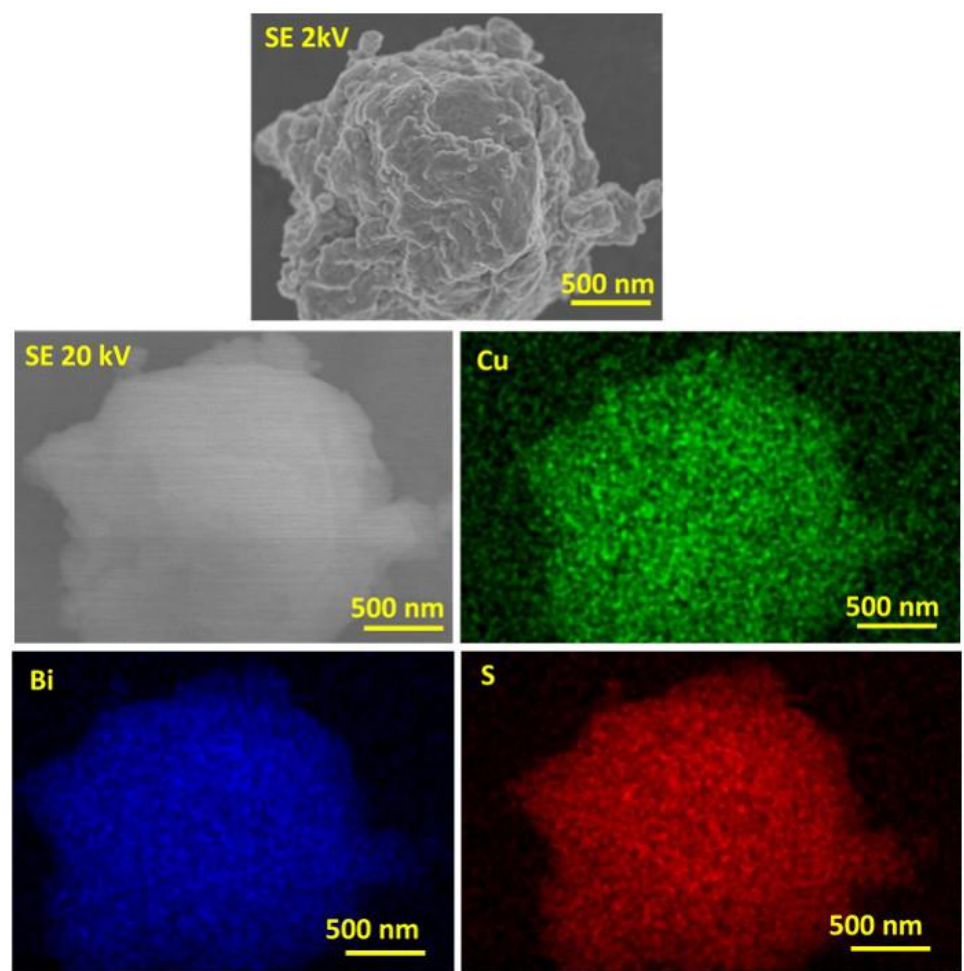
Figure 5. SEM images (2 and 20 kV) of mechanochemically synthesized Cu 3 BiS 3 after 5 min of mill- ing and elemental mapping results (EDX at 20 kV) showing Cu, Bi and S distribution. and elemental mapping results (EDX at 20 kV) showing Cu, Bi and S